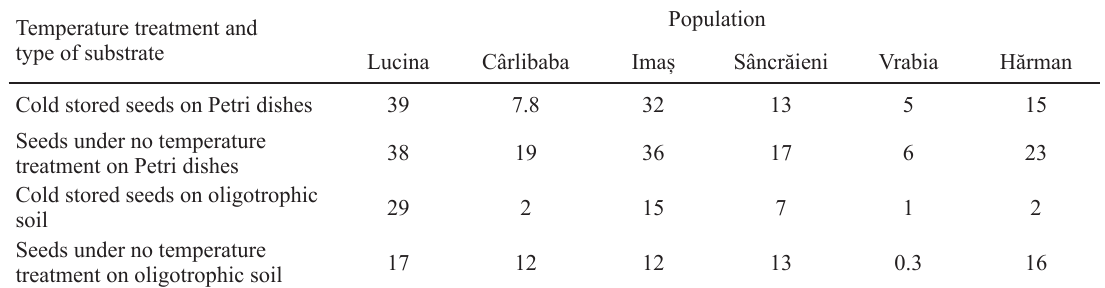
Table 4 – Seed germination (%) under different temperature treatments and on different types of substrate. The values represent the percent of the total number of germinated seeds in each experimental form at the end of the